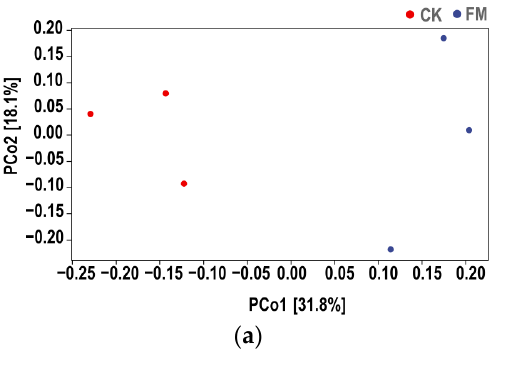
Figure 3. Principal coordinate analysis (PCoA) of bacterial ( a ) and fungal ( b ) communities; PCoA analysis was performed based on the weighted UniFrac distance of the bacterial and fungal com- munities.